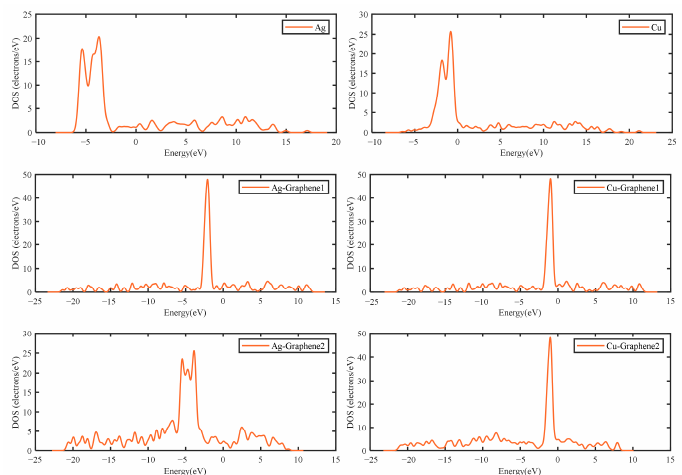
Figure 5. DOS of different electrode plates.